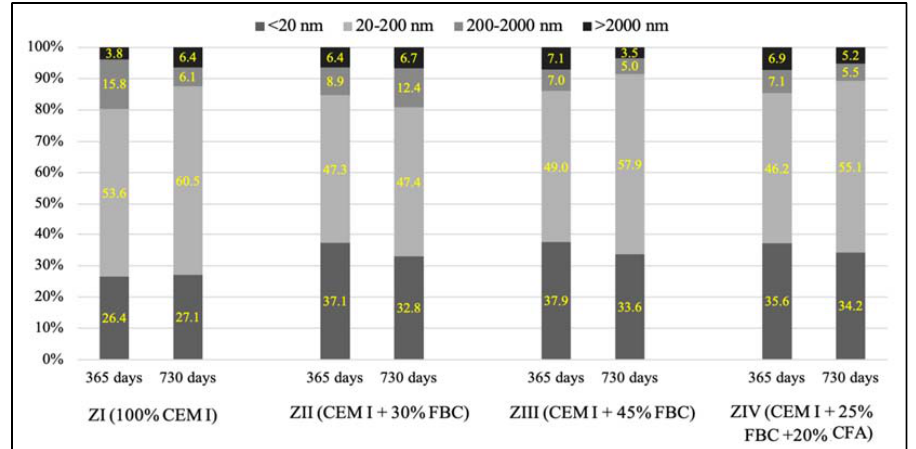
Figure 30. Pore size distribution for the ZI–ZIV mortars stored in the 1% HCl solution after 365 and 730 days.